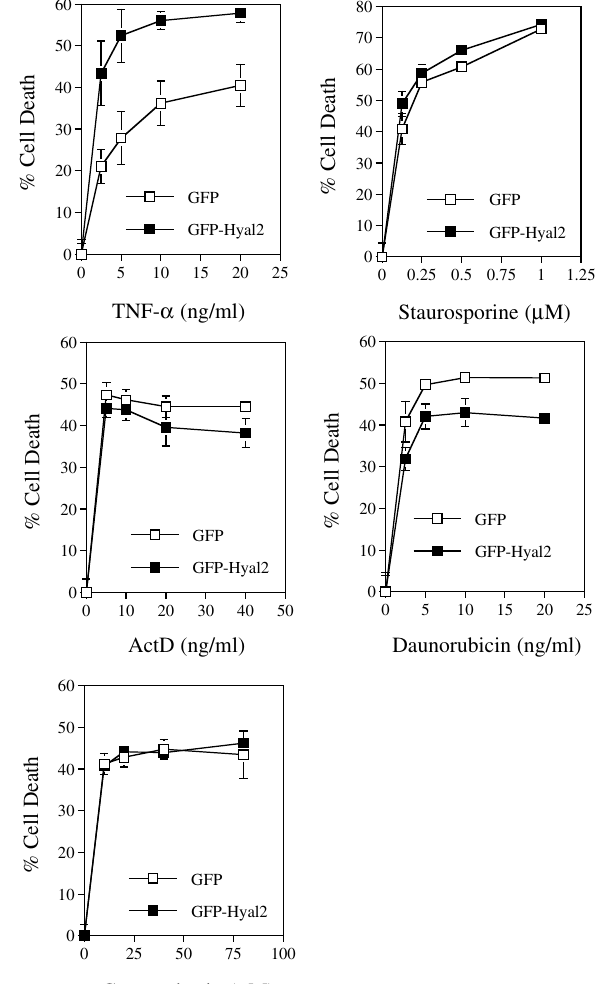
Figure 2 Hyal-2 increases L929 cell sensitivity to TNF cytotoxicity. L929 cell lines that stably expressed GFP and GFP-Hyal-2 were established (see Materials and Methods) and exposed to TNF- α , staurosporine, actinomycin D (ActD), daunoru- bicin, or camptothecin for 24 hr. The extent of cell death were measured by staining the cells with crystal violet as pre- viously described (mean ± standard deviation; n = 8)